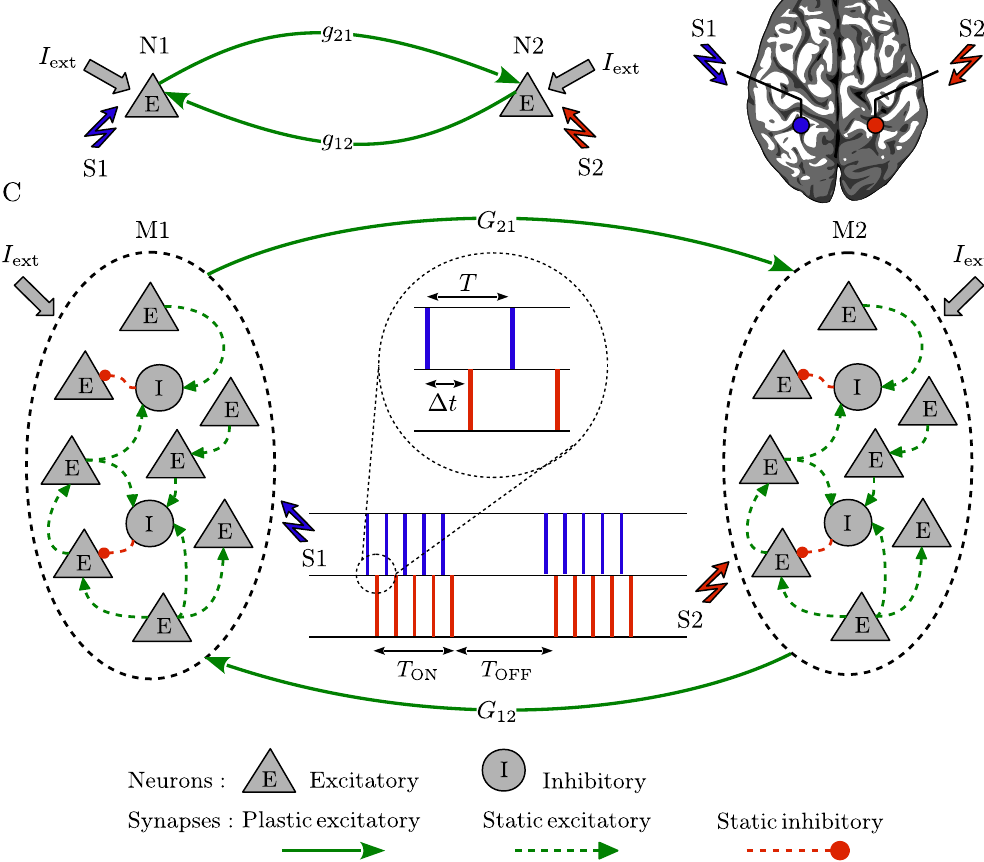
Fig 1. Representation of the two-neuron motif and neuronal network. ( A ) Two excitatory neurons coupled by reciprocal plastic synapses with strength g 21 / g 12 . ( B ) Schematic of the brain and the stimulation electrodes (circles) where the two stimulation signals (S1/S2) were separately delivered to two representative populations in panel C, e.g., in two hemispheres. ( C ) Two reciprocally connected neuronal populations (modules) characterized by inter-population excitatory-to-excitatory plastic synapses with mean coupling G 21 / G 12 . Each stimulation signal consists of intermittent bursts where T represents inter-pulse interval within a burst and Δ t is the time shift between the two stimulation signals delivered to each module. T ON is the stimulation ON-epoch for each stimulation burst and T OFF is the stimulation OFF-epoch between two successive bursts within each stimulation signal.